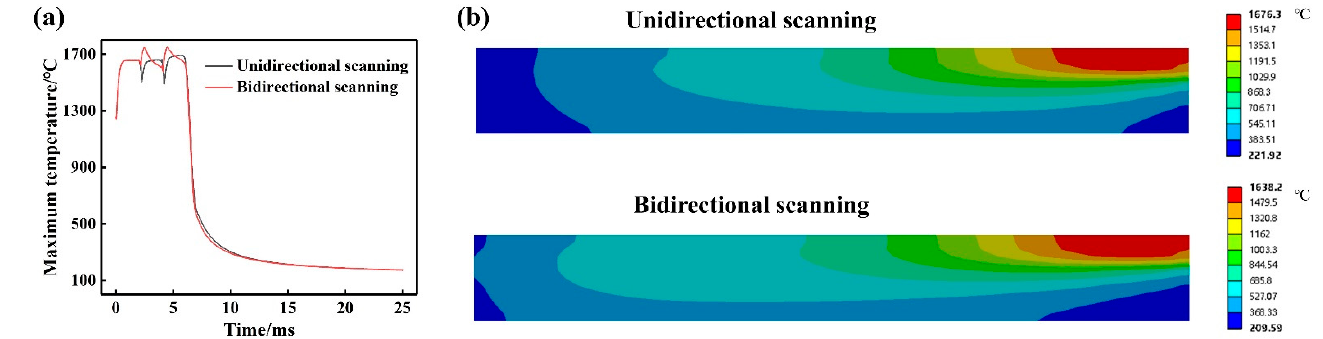
Figure 4. ( a ) The simulation curves of maximum temperature under different linear scanning; ( b ) temperature field distribution of different linear scanning at the same time. ( b ) temperature field distribution of different linear scanning at the same